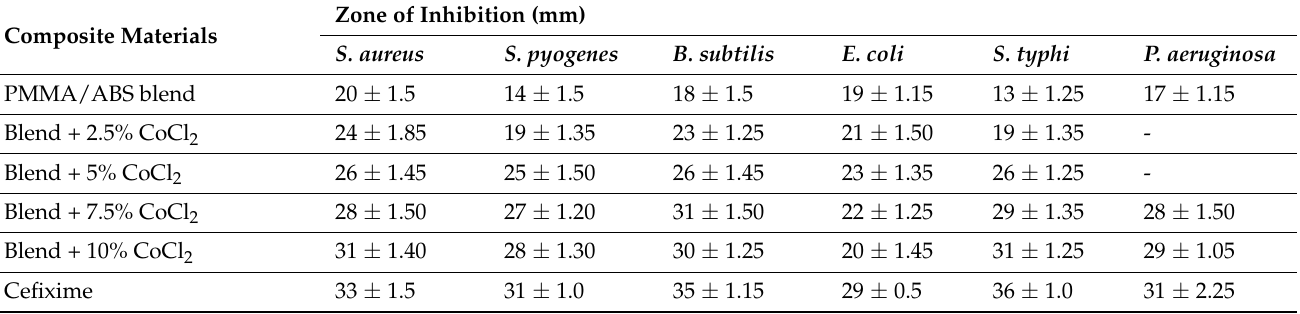
Table 2. Antibacterial data of a PMMA/ABS/nCoCl 2